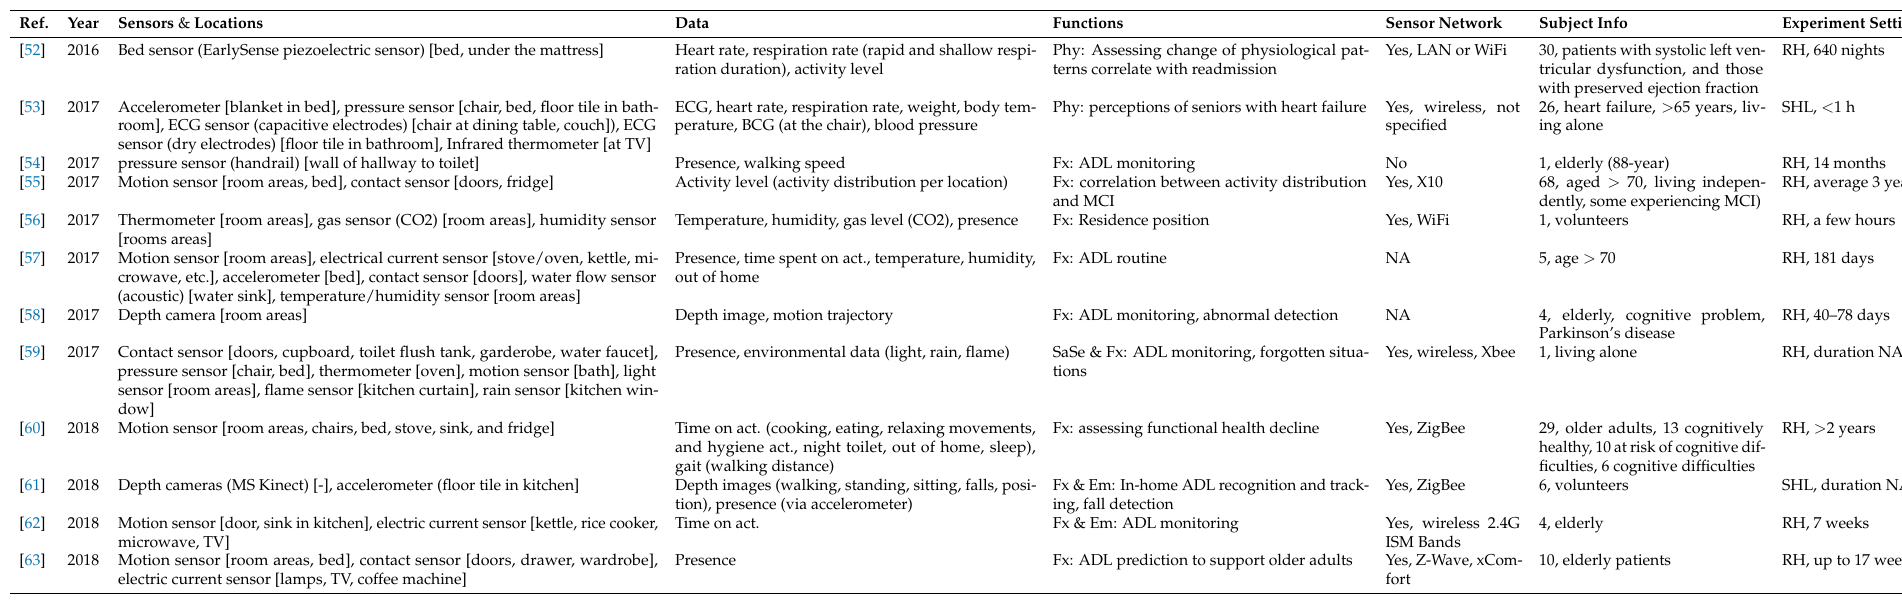
Table 2. Recent research on in-home health monitoring (continued). NA: not available. RH: real home. SHL: smart home